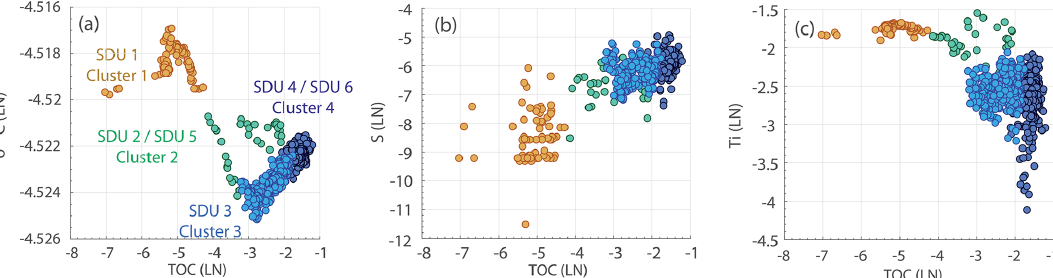
Figure 8. Comparison of bulk geochemistry and XRF data from composite profile KKJ19. (a) δ 13 C of organic material ( δ 13 C org ) and total organic carbon (TOC). (b) S and TOC. (c) Ti and TOC. Colors of the data points correspond to those of the cluster analysis. XRF profiles were resampled to the resolution of the bulk geochemistry